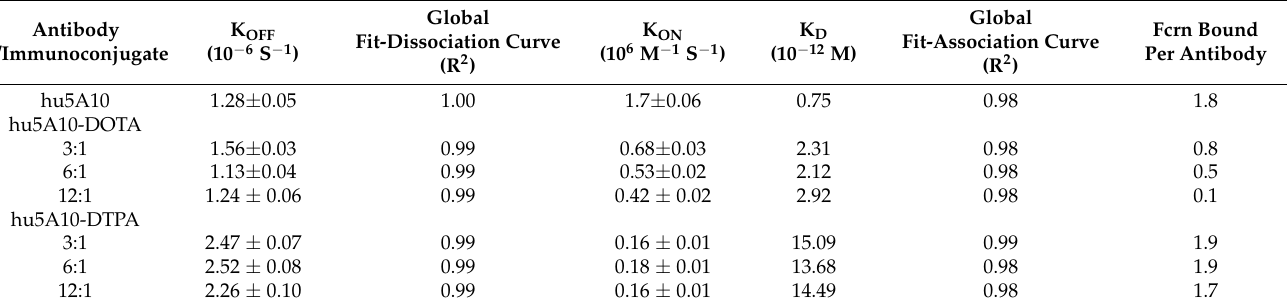
Table 1. The impact of different conjugation chelator-to-antibody ratios for two common bifunctional chelators (CHX-A”- DTPA or DOTA) on the binding kinetics to the target fPSA and FcRn, measured by SPR using a Biacore instrument. The results showed that labeling under increasing amounts of DOTA chelator affected the FcRn binding the most, whereas the same was true for fPSA binding with the DTPA chelator.